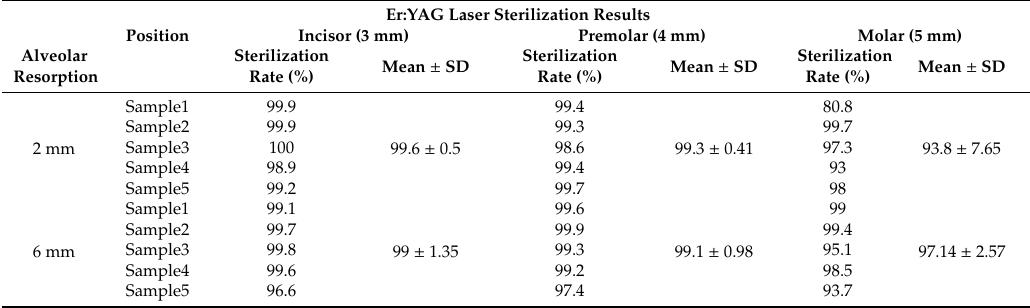
Table 3. Erbium-doped yttrium, aluminum and garnet (Er:YAG) laser sterilization results with di ff erent levels of alveolar resorption and